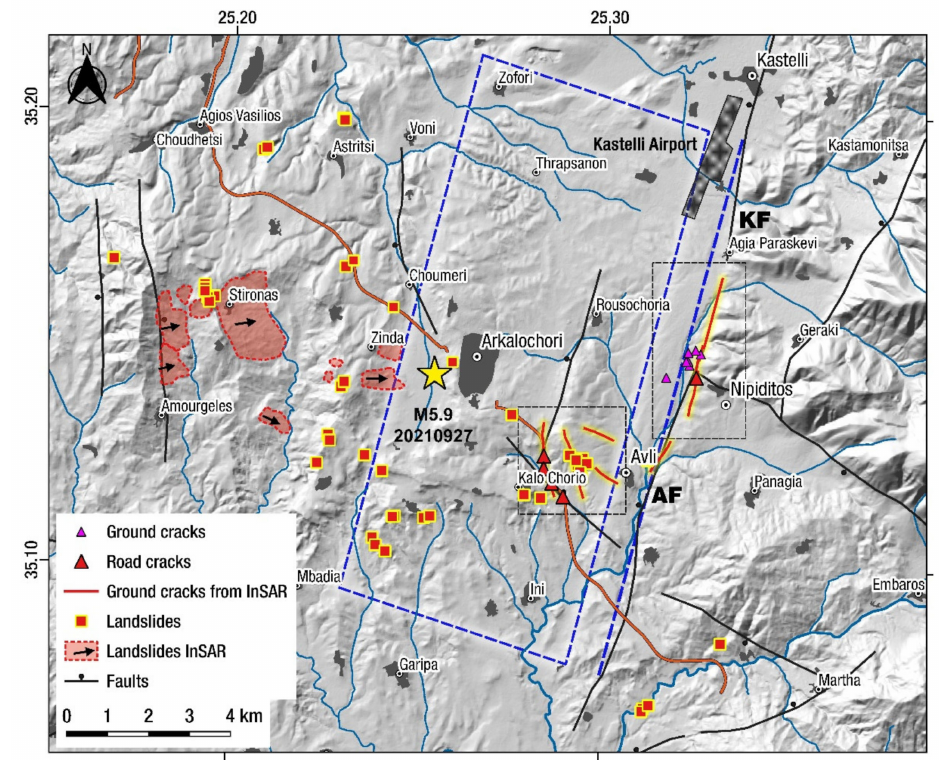
Figure 10. Relief map showing earthquake effects mapped by field surveys during the period September–November 2021 (by CF, AG, SV, IK) and satellite imagery (InSAR wrapped interferogram disruptions and features on Sentinel-2 optical imagery). Yellow star is relocated epicentre of the mainshock. Blue rectangle is the surface projection of the modelled fault. Dashed blue line indicates the intersection of the seismic fault with the Earth’s surface. KF is Kastelli Fault, AF is Avli-Lagouta Fault. Orange line is the Heraklion-Arkalochori